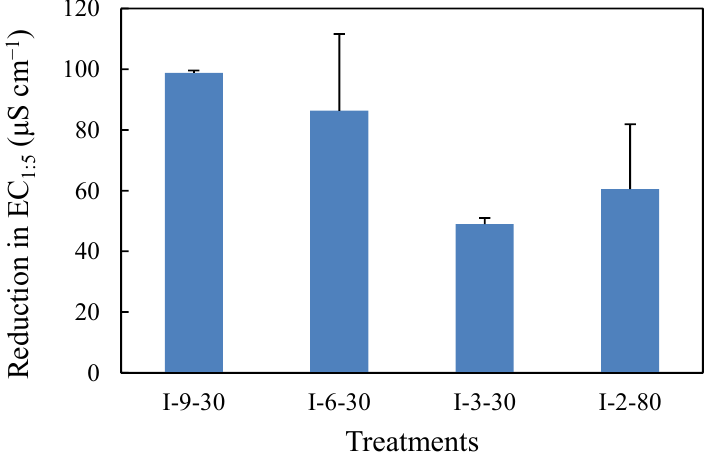
Figure 5. Change in root zone soil EC ( μ S cm − 1 ). The error bars represent the standard